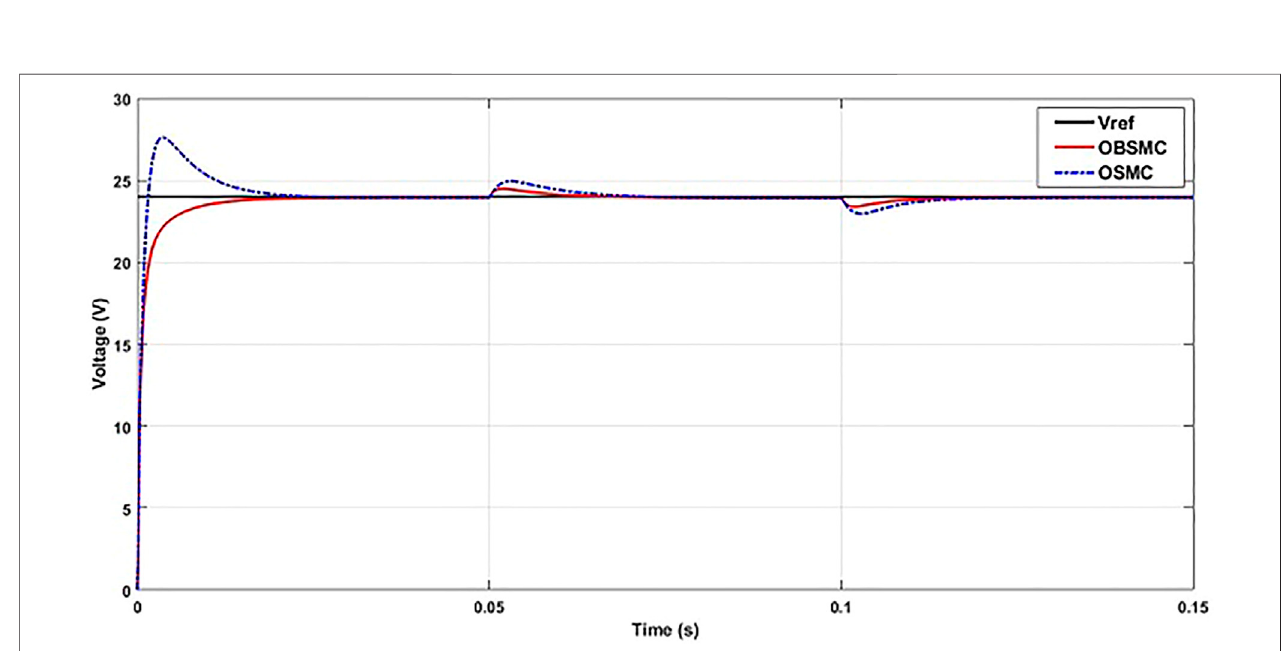
FIGURE 9 | Output voltage of the converter for load resistance variations.